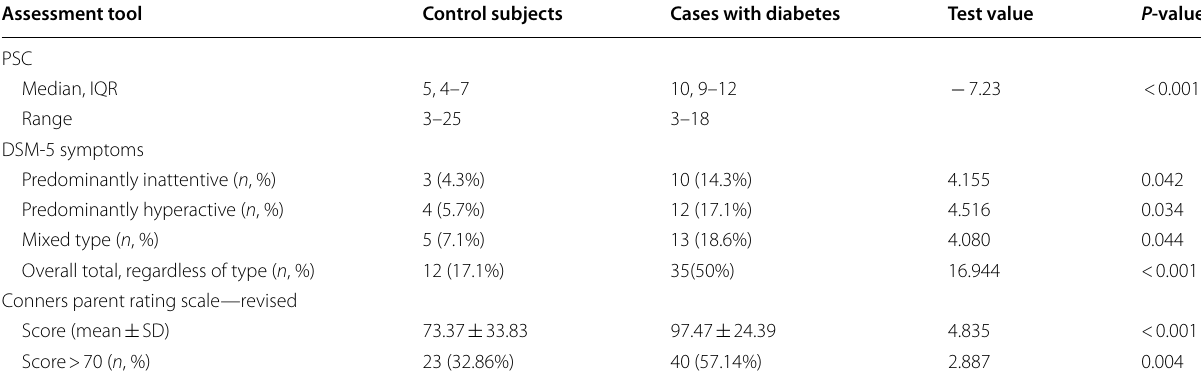
Table 2 Psychometric evaluation results of included cases with diabetes and controls Assessment tool